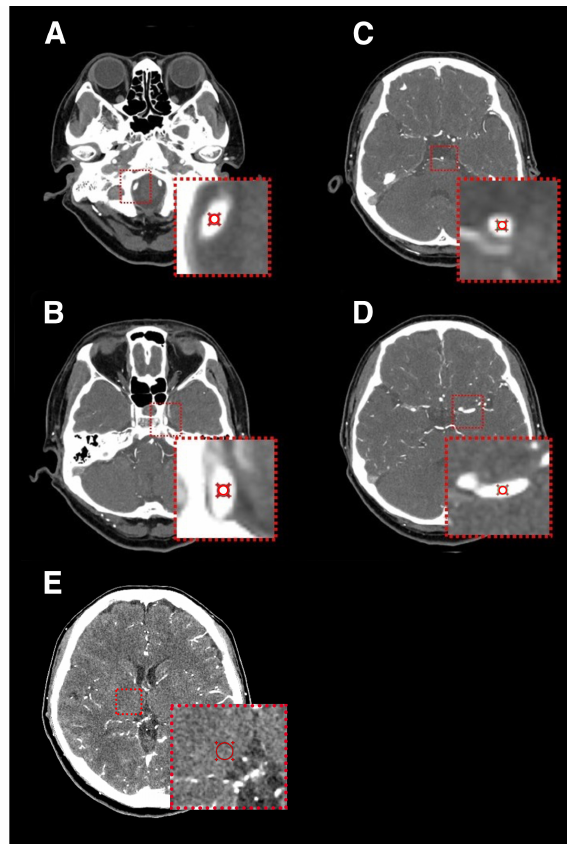
Fig.2. MeasurementsofobjectiveimagequalityinthebrainCTA. The regionofinterest(ROI)wasplacedinthecenteroftherightandleftvertebral artery (A), basilar apex (B), right and left cavernous segment of the internal carotid artery (C), right and left M1 segments of the middle cerebral artery (D),andrightthalamicgraymatter(E)avoidingtheinclusionofavesselwall at the same position in the three image reconstructions with DLR, Hybrid IR, and